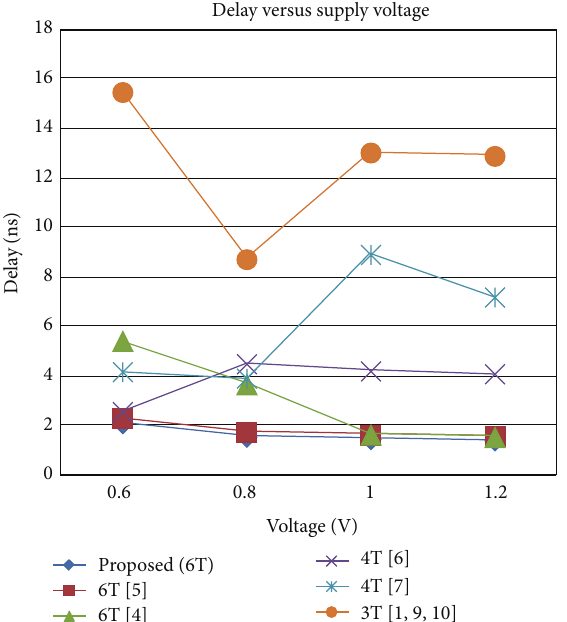
Figure 3: Line graph showing the comparison of the propagation delay versus supply voltage scaling for different CMOS XOR gates with the proposed novel CMOS pass-transistor-based full-swing XOR gate.